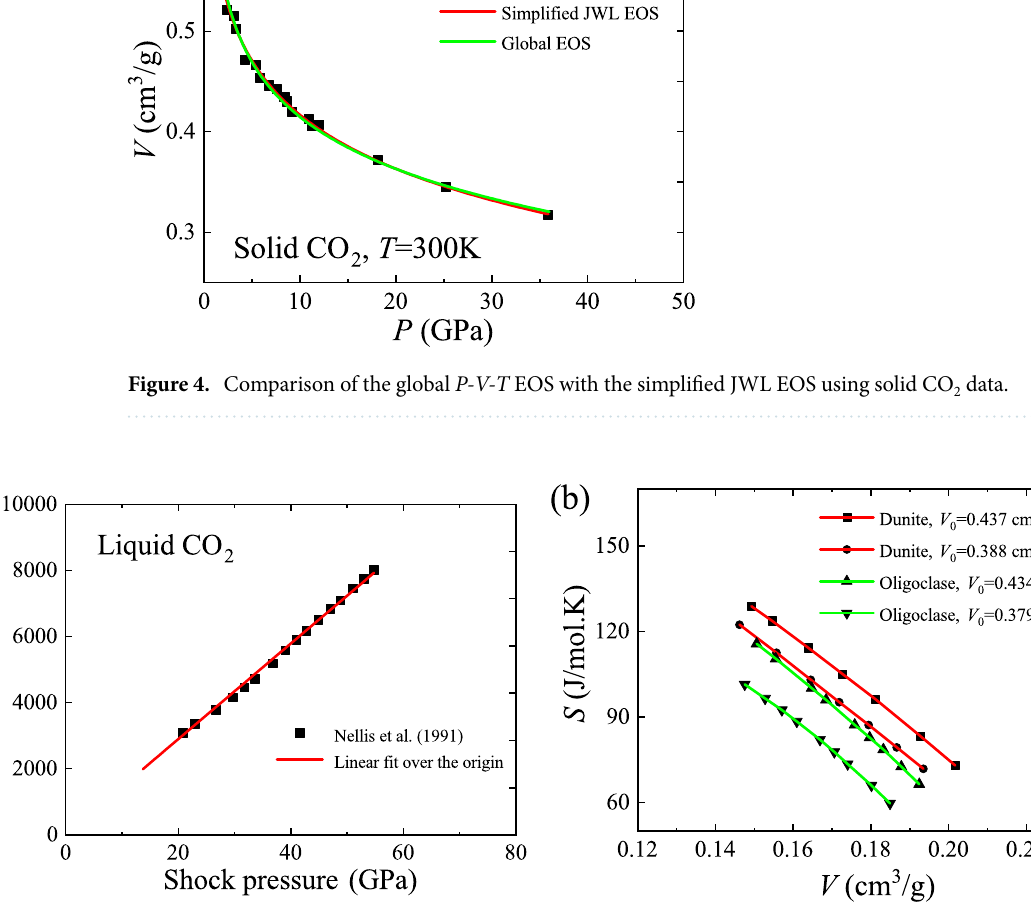
Figure 5. Shock-Hugoniots. ( a ) Shock temperature versus shock pressure for liquid CO 2 ; ( b ) entropy versus volume for dunite and oligoclase, where V 0 is initial